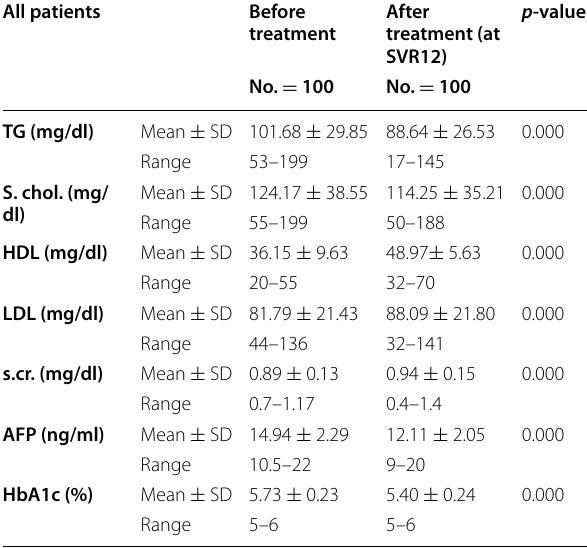
Table 2 Comparison between all studied patients’ data before and after treatment All patients